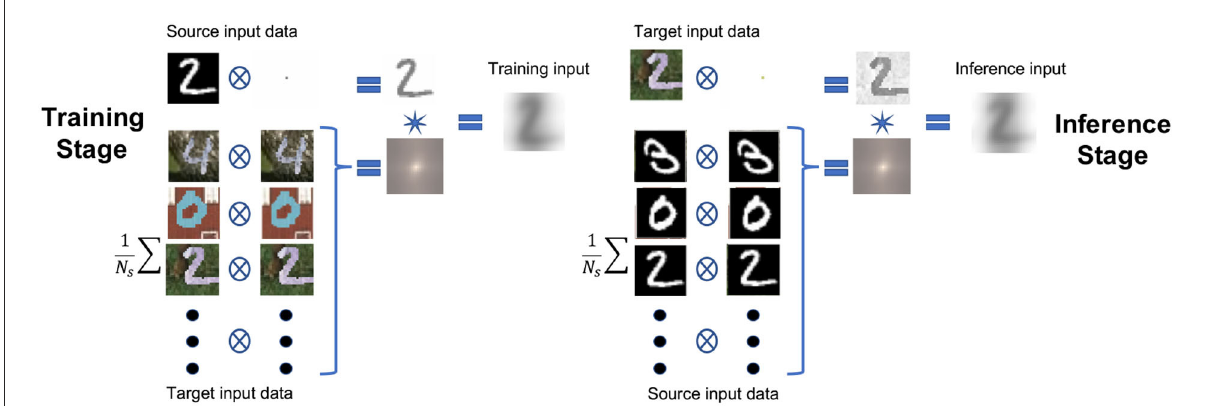
FIGURE2 The workflow chart for the proposed data adaptation applied as an example to the MNIST/MNIST-M datasets. On the left, the proposed process used for producing the training data; on the right, the proposed process used for producing the testing/application data. The circled cross symbol denotes a cross-correlation operation, and the star symbol denotes a convolution